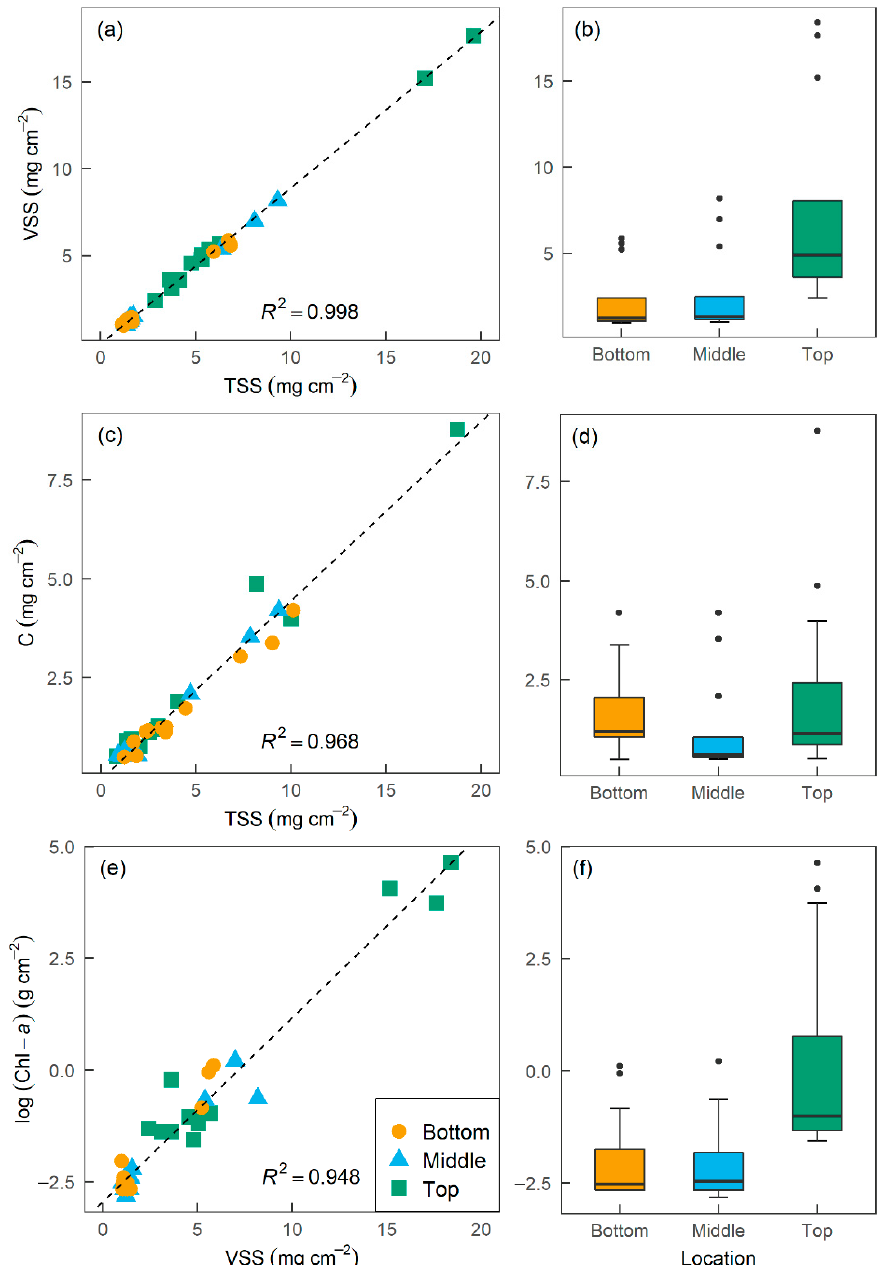
Figure 6. Relationship between selected water quality variables and the baffle samples taken at three points through the water column. Five variables were selected for analysis: volatile suspended solids (VSS); total suspended solids (TSS), including TSS samples and TSS values recorded from particulate carbon and nitrogen samples; attached carbon content (C); and chlorophyll- a (chl- a ). Here, it can be seen that ( a ) VSS, ( c ) C, and ( e ) chl- a are more abundant and have a larger range in the upper water (top) column (b, d, f, respectively). Samples collected in the middle and lower parts of the water column (middle and bottom) have similar interquartile ranges for VSS ( b ) and chl- a ( f ) content. In the linear analyses ( a , c , e ), dashed lines represent the line of best fit and R 2 reflects the strength of fit. Log transformations for chl- a values are natural log. In boxplots ( b , d , f ), boxes show quartiles 1 (25%) and 3 (75%) with the median, whiskers show the minimum and maximum values, and dots indicate outliers.